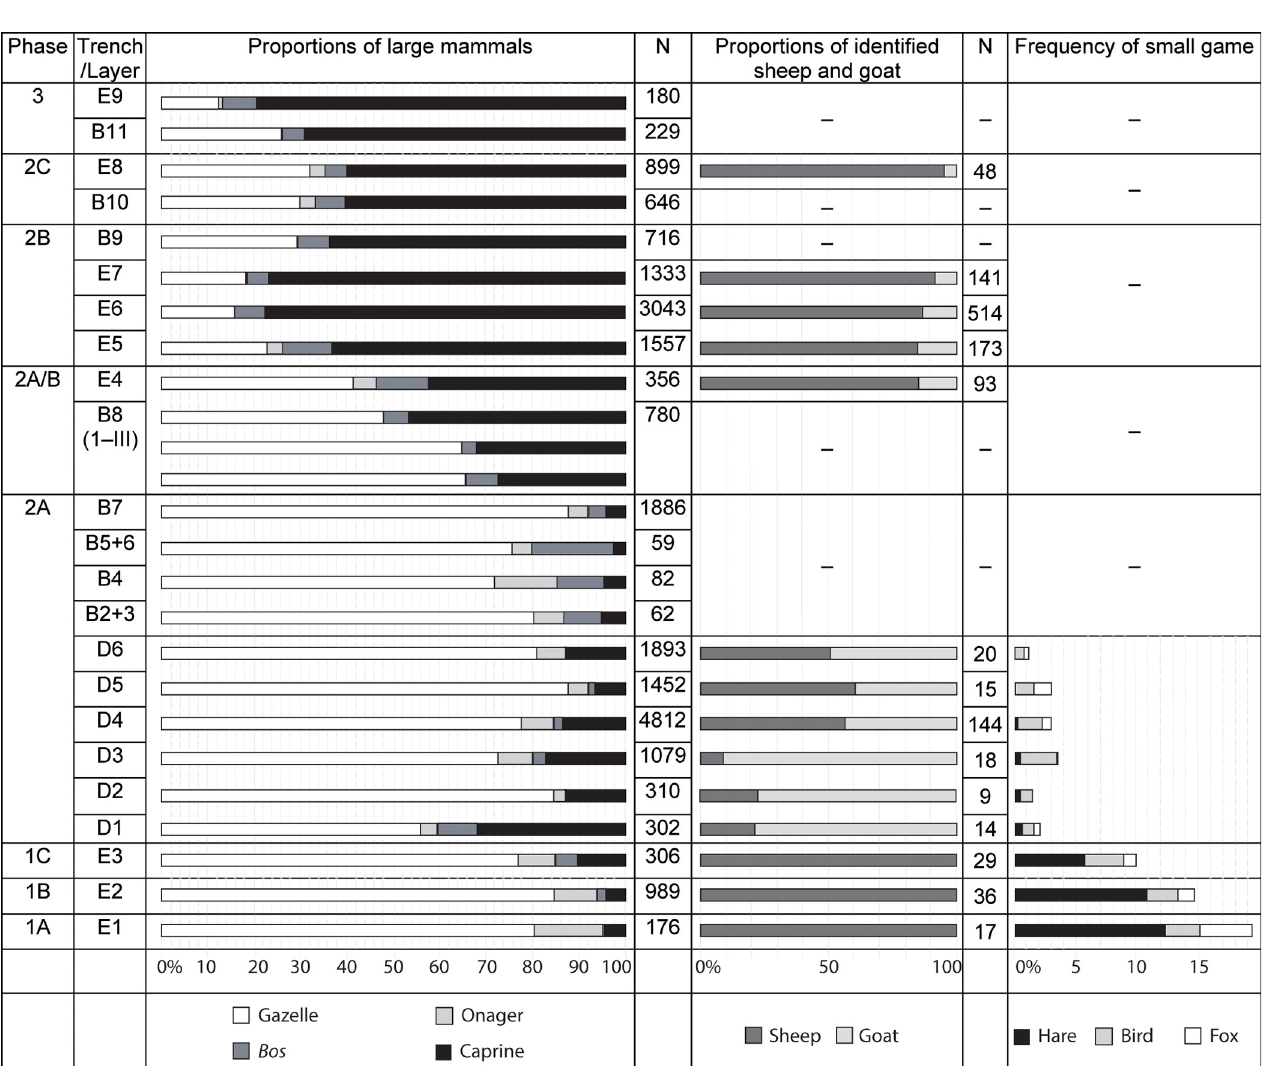
Fig 3. Bar charts illustrating relative proportions of large mammals (left), sheep and goat (center), and small game (right) within the Abu Hureyra sequence. All of the zooarchaeological data presented here were obtained from published reports produced by Legge and Rowley-Conwy [1, 76]. Following the method used by Colledge and Connolly [47] to explore published archaeobotanical data from Abu Hureyra, relative proportions and frequencies of fauna were obtained by measuring the length of the bars within Figs 13.6, 13.7, 13.8, and 13.1 from Village on the Euphrates [1]. Lengths of bars were measured in mm using low-power microscopy (10 × ) using the mid-point of lines at either end of the bar.– = no data